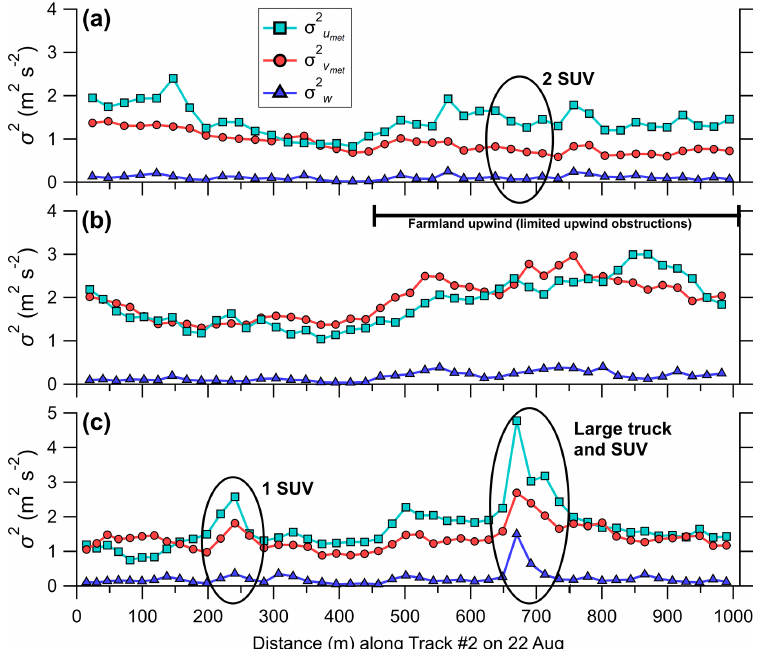
Figure 7. Car-measured velocity variances on three different 1000m tracks, calculated every second using wavelet analysis. The data shown are from 22 August. The black circled areas denote the passage of traffic in the lane adjacent to the instrumented car (i.e., traveling in the opposite direction), as determined from visual inspection of the dashboard camera video. The text located to the right of the circle gives the traffic composition. The data shown are measurements from the lane closet to the tripod. The velocity variances shown are in a meteorological coordinate system.